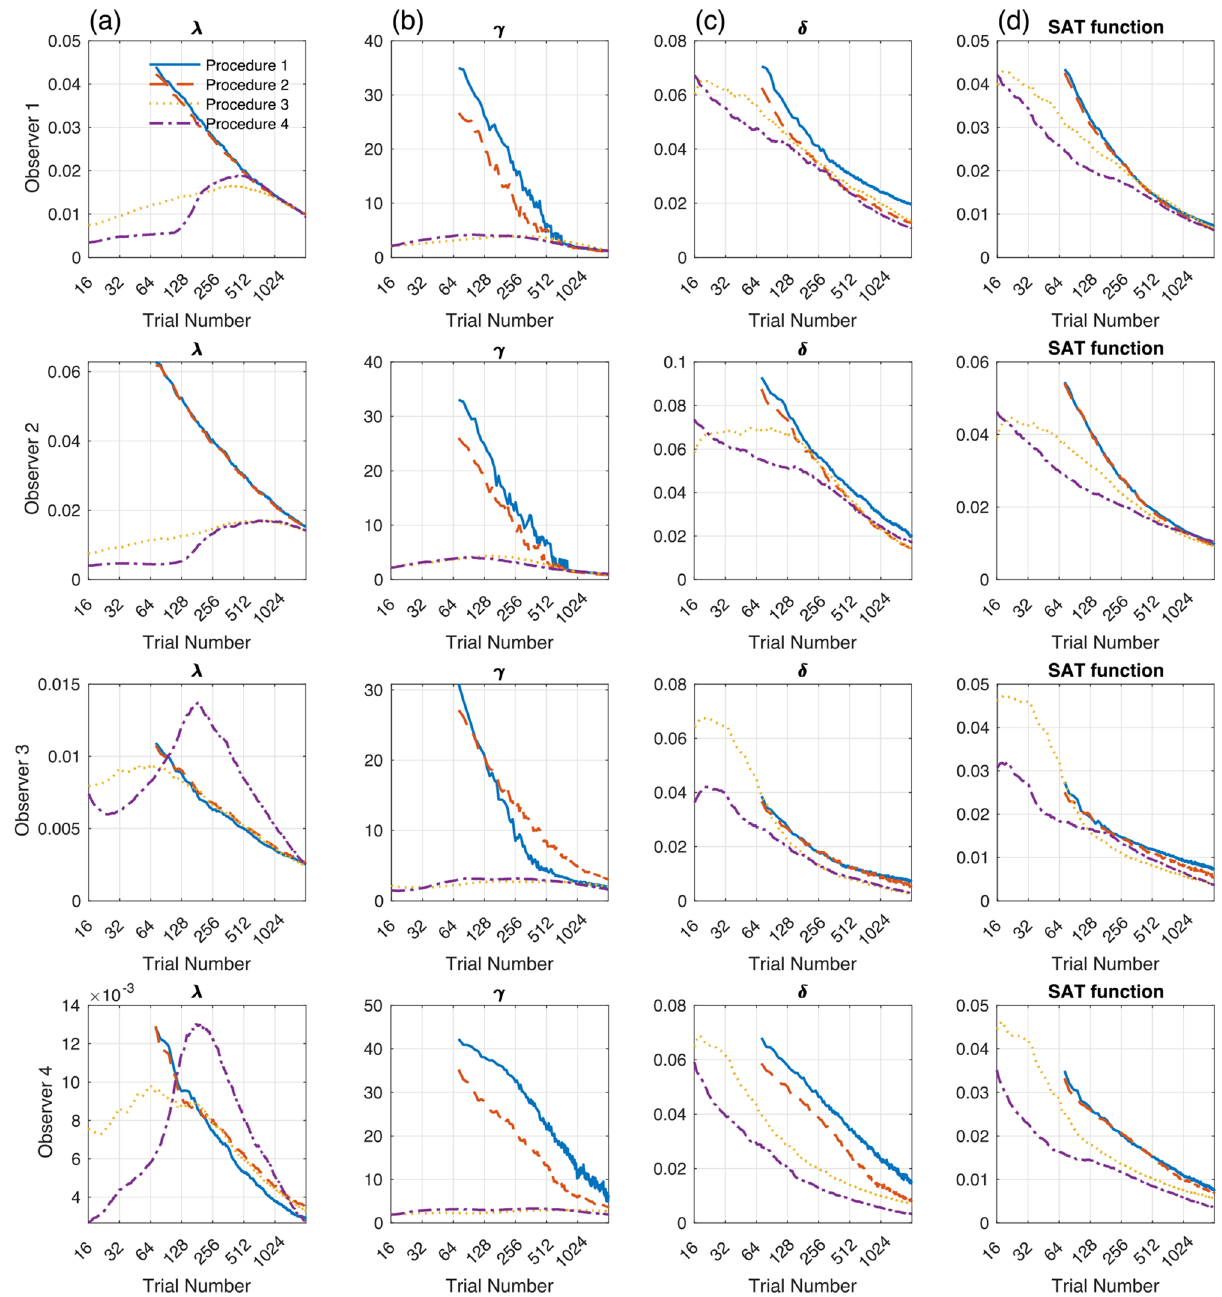
Figure 6. The precision of estimated SAT parameters and function with four estimation procedures for four simulated participants. The standard deviation of ( a ) λ, ( b ) γ, and ( c ) δ estimates was plotted as a function of trial numbers. In each panel, different procedures were presented with different colors. Procedure 4 showed better precision (smaller standard deviation) than the other procedures, especially for a small number of trials. ( d ) The standard deviation of the estimated SAT functions was also smaller with Procedure 4 than with the other procedures. ( Note. Procedure 1: Maximum likelihood estimation with mean RT and accuracy; Procedure 2: Maximum likelihood estimation with trial-by-trial RT and accuracy; Procedure 3: Bayesian estimation without optimal stimulus selection; Procedure 4: Bayesian adaptive estimation with optimal stimulus